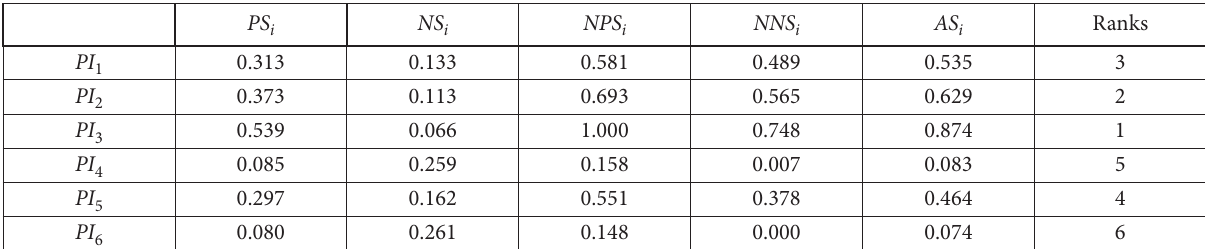
Table 3. The calculation results and ranking of institutions derived by the EDAS